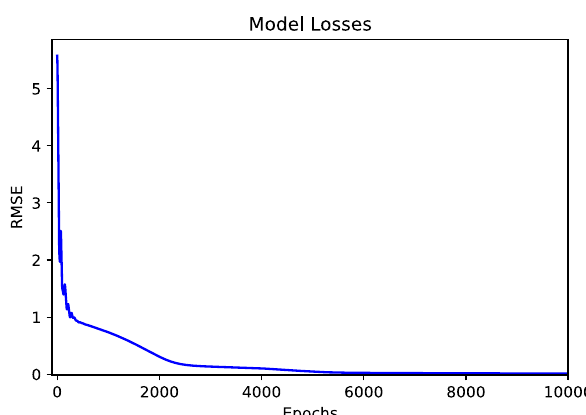
Fig. 22 Effect of Nt versus M on −Θ � ( 0 )